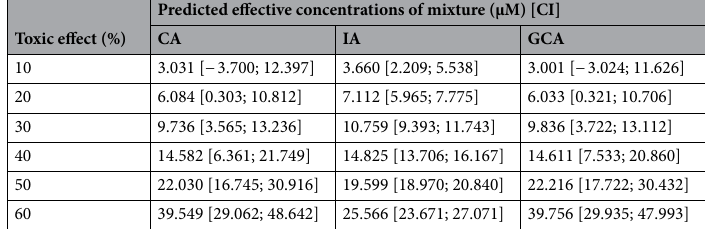
Table 3. Summary of predicted effective concentrations of mixture for Case Study